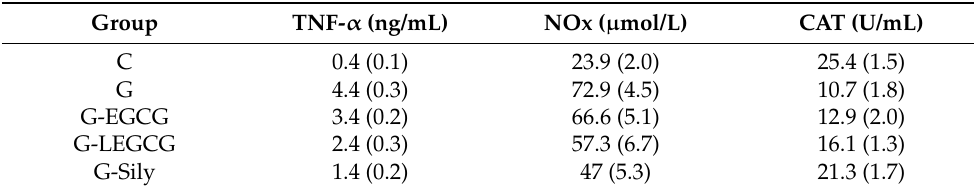
Table 4. Serum markers of inflammation, oxidative stress/antioxidant balance by groups after gentamicin administration: comparative effect of EGCG, LEGCG, and silymarin.